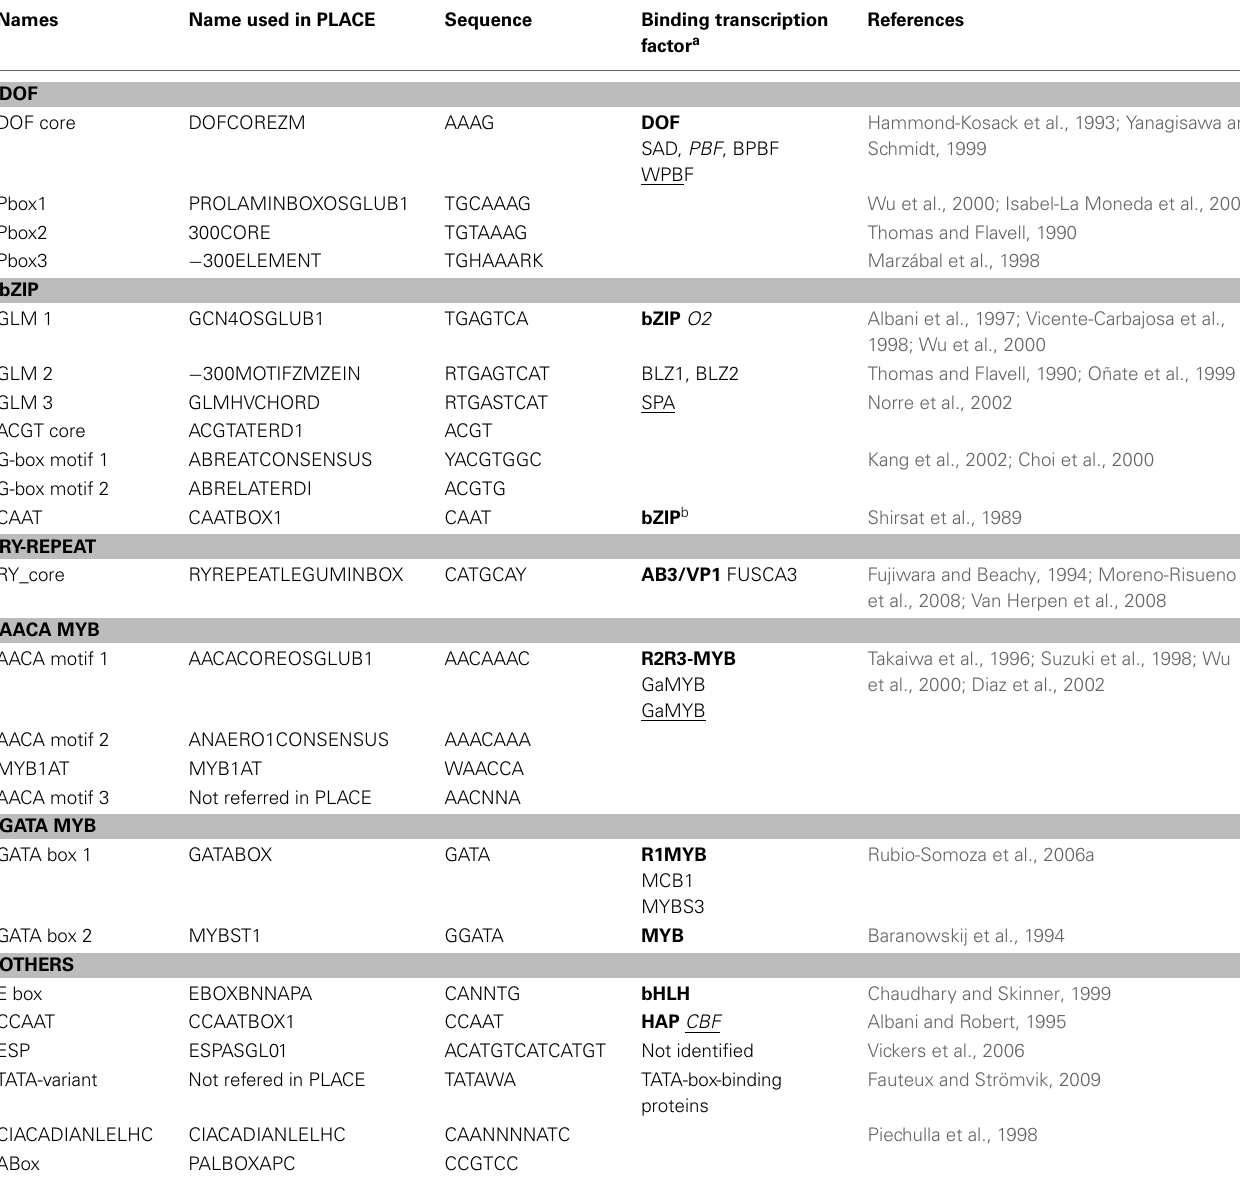
Table 2 | Characteristics of cis -motifs from PLACE database and bibliographic references used to annotate the promoters of HMW-GS